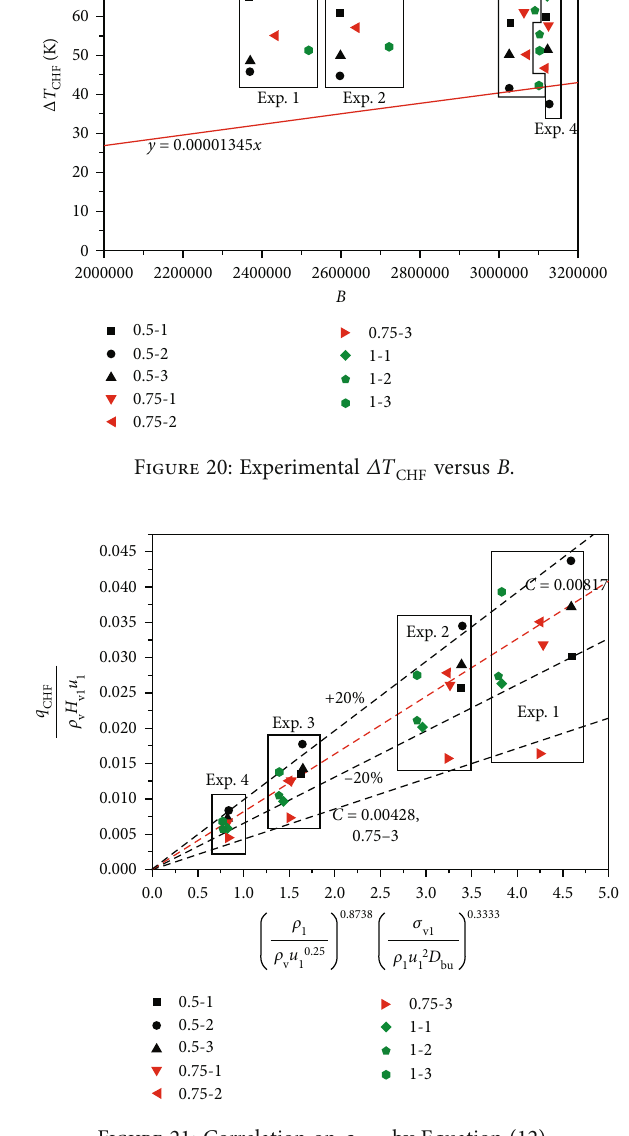
CHF by Equation (12).